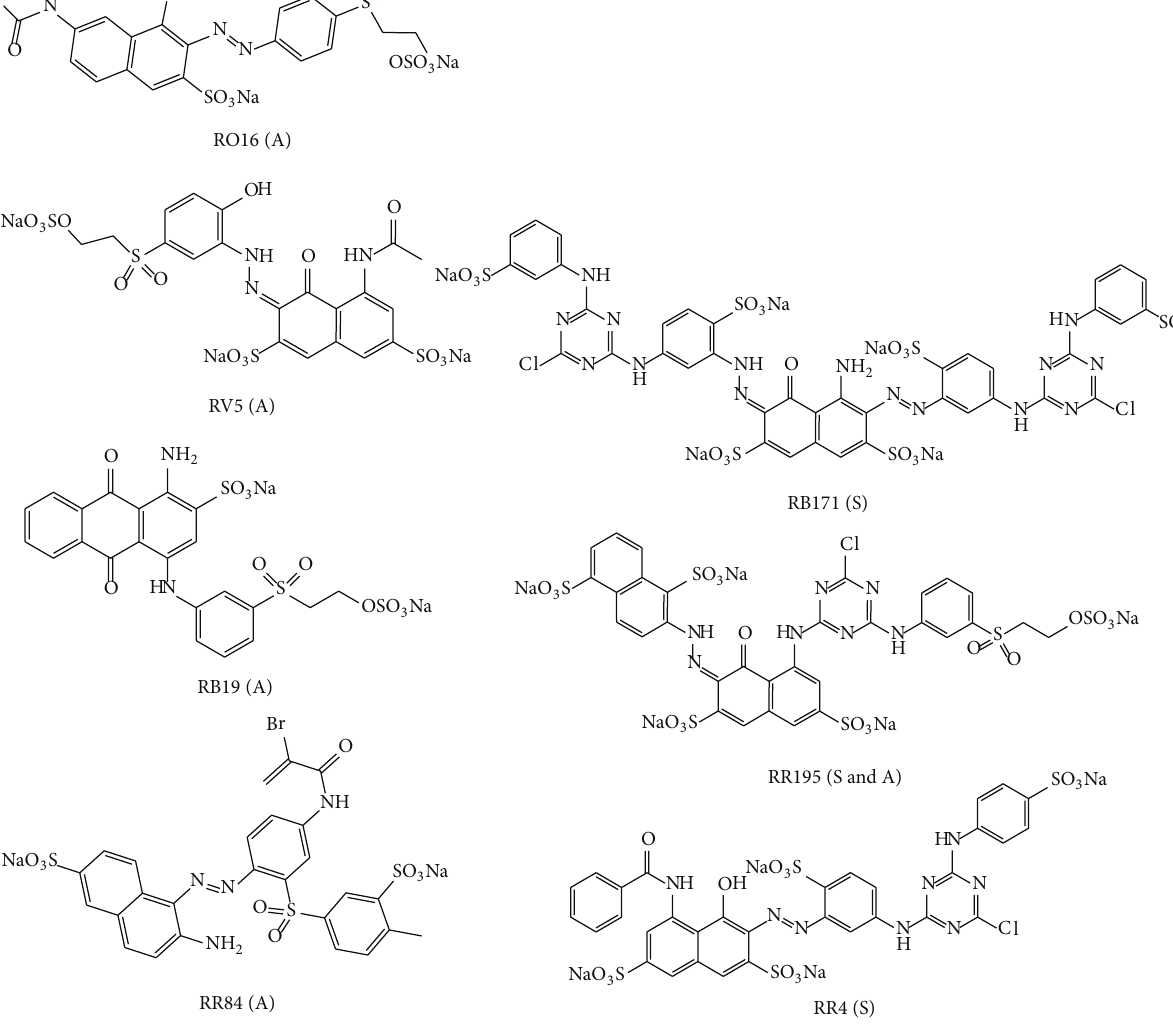
Figure 1: Nucleophilic substitution (S) and nucleophilic addition (A) type reactive